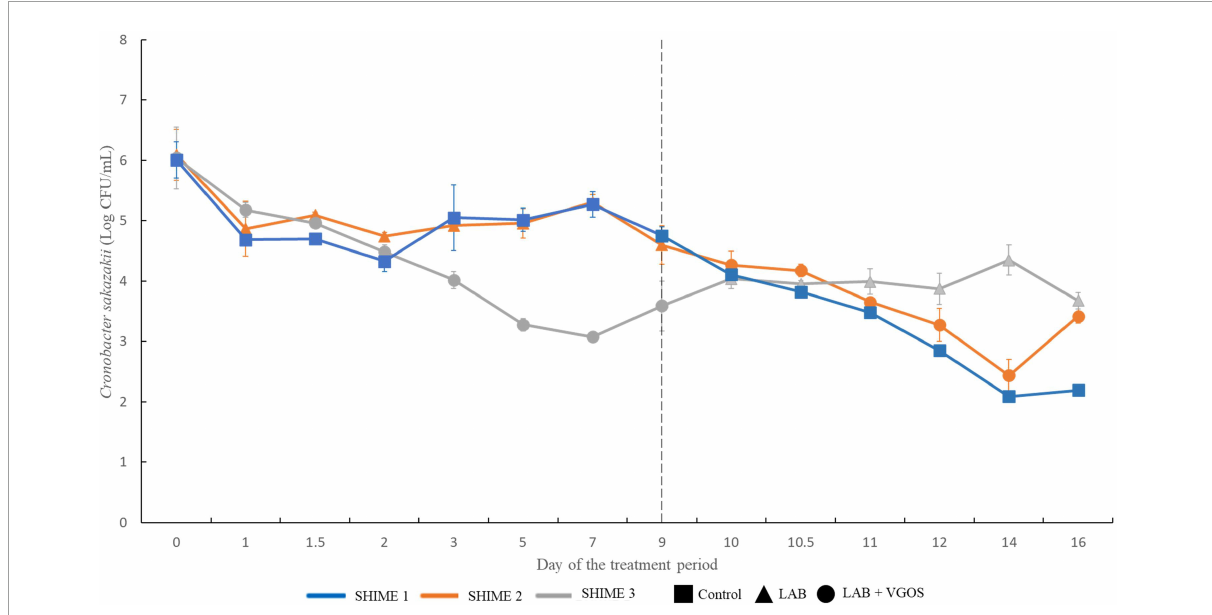
FIGURE2 Survival of C. sakazakii in different SHIME compartments and under different treatment conditions ( n = 2). At all time points, C. sakazakii was plated on Brilliance C. sakazakii agar. The gray dotted line indicates the start of the second treatment period. Values are the average of C. sakazakii plate counts from the proximal and distal colon vessels ± the standard